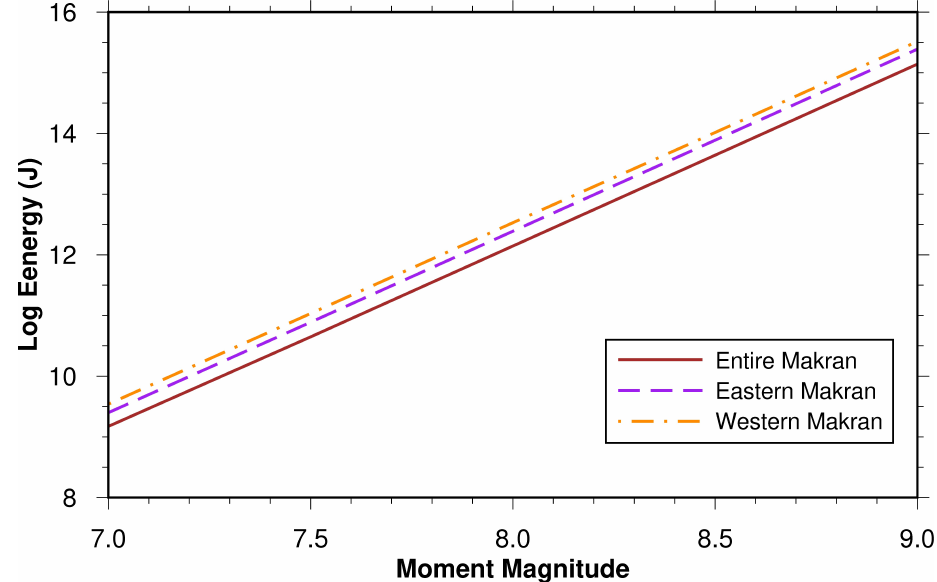
Figure 7. Relationship between moment magnitude and tsunami wave energy for the entire, western and eastern Makran (modified after